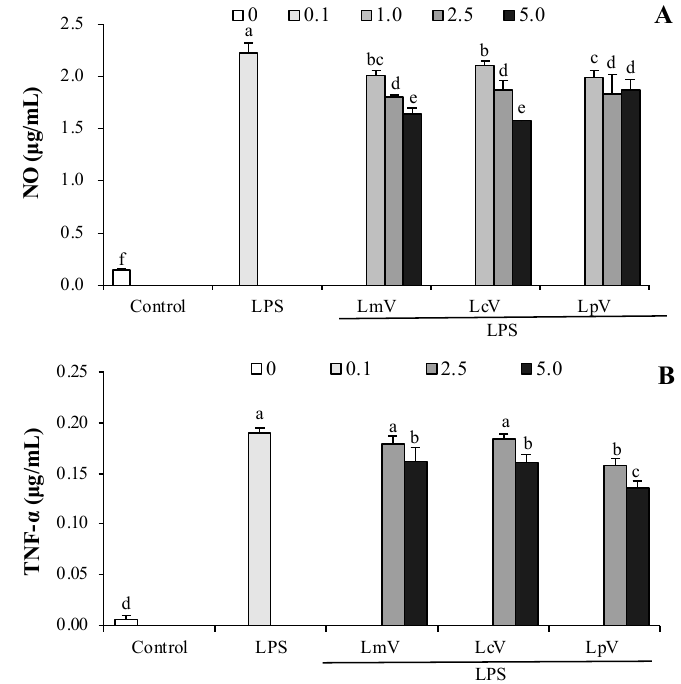
Parkinson’s, Alzheimer’s, and other neurodegenerative diseases are induced by neu- roinflammation of brain cells including microglia, which are brain-resident myeloid cells that support the central nervous system. Activated microglia represent a common patho- logical feature of several neurodegenerative diseases, including Alzheimer’s disease [16]. NO secretion in LPS-induced microglial cells were inhibited by LmV-, LcV-, or LpV-pre- treatment (Figure 6A). LmV, LcV, and LpV inhibited LPS-induced TNF- α , IL-1 β , and IL- 6 production (Figure 6B–D).